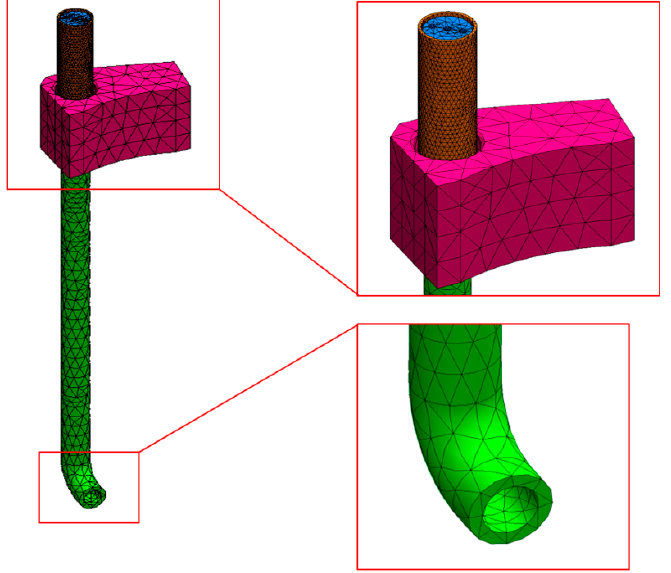
Figure 8. Model meshed with tetrahedral elements to analyse the stress in the overflow valve in the FEM module.